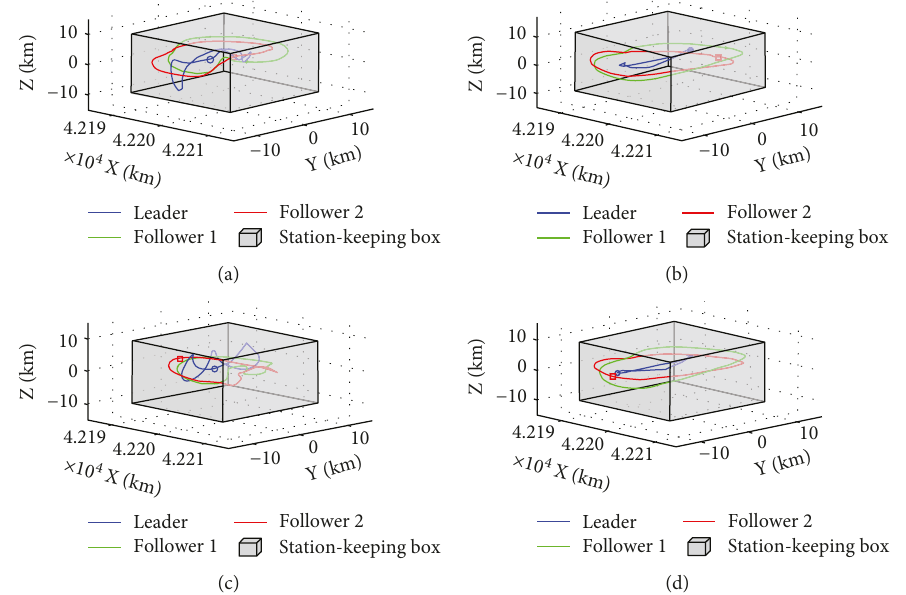
Figure 9: Loosely formation with station-keeping box: the trajectories of hybrid sail on (a) winter solstice, (b) spring equinox, (c) summer solstice, and (d) autumn equinox in the inertial